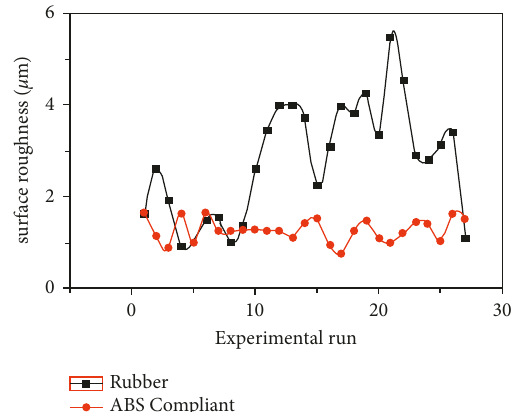
Figure 7: Comparison of the average cutting force with the rubber and ABS compliant damper.